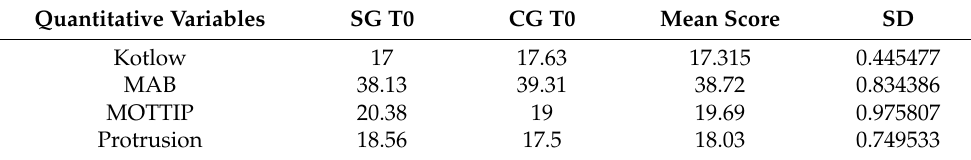
Table 4. Comparison between the SG and the CG at T0 in relation to the quantitative variables.